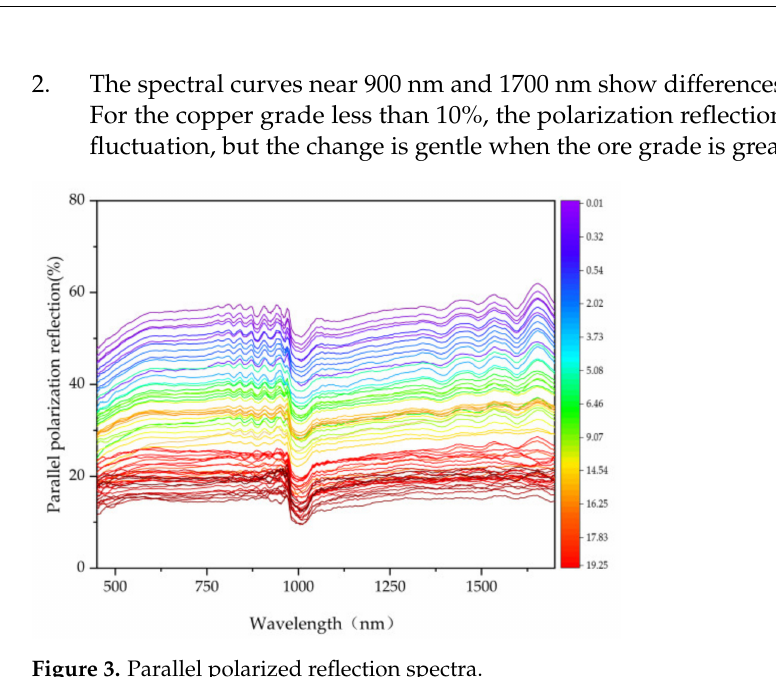
Figure 3. Parallel polarized reflection